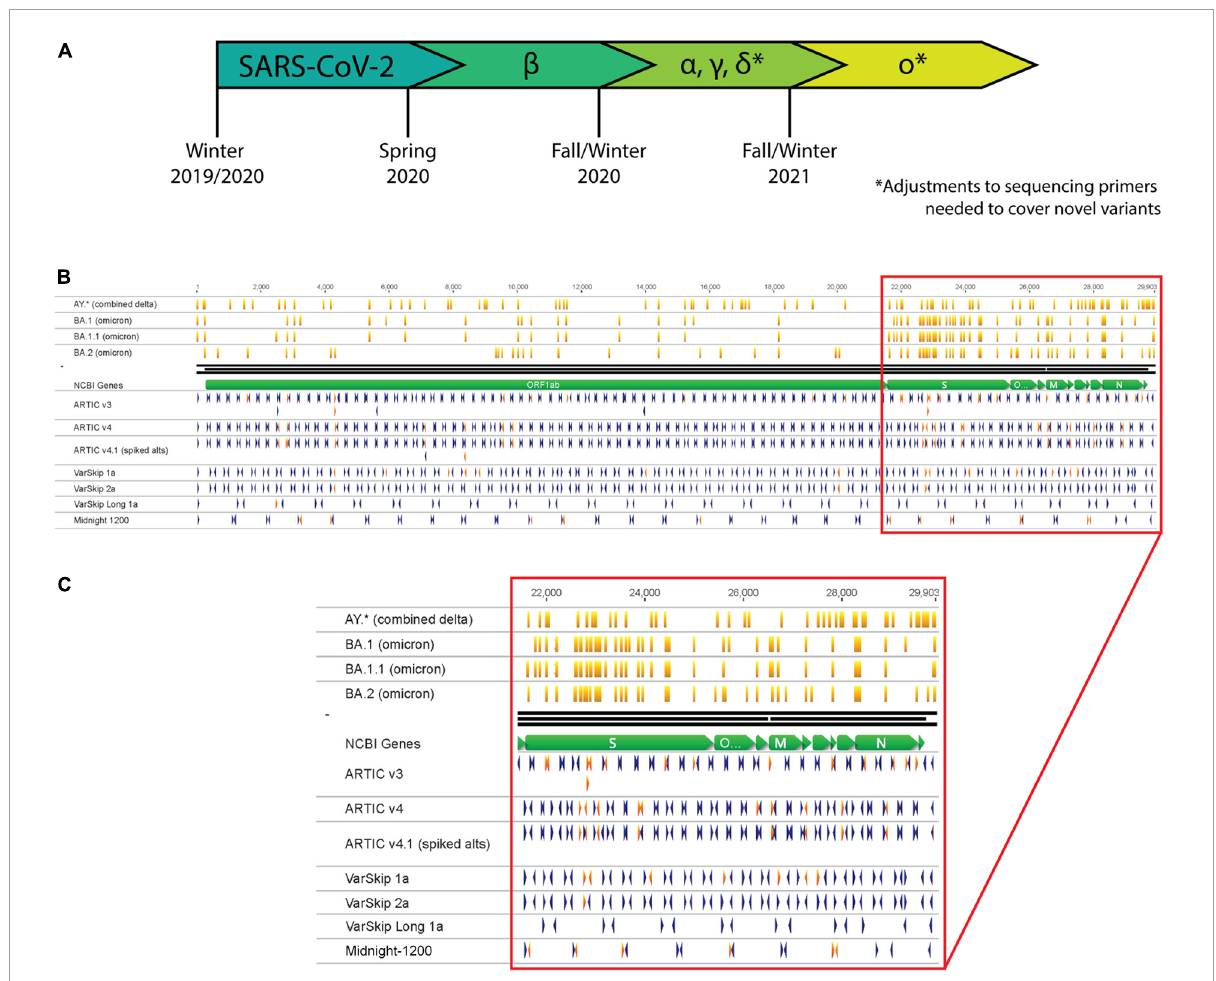
FIGURE1 SARS-CoV-2 variants necessitate continual assessment of primers utilized for sequencing as variants overlap with primer sites. (A) Timeline representing the emergence of SARS-CoV-2 variants as determined by continual variant monitoring via sequencing. (B) Analysis of Delta and Omicron variants overlapping with primers from several SARS-CoV-2 primer schemes. Orange vertical lines mark mutation locations along variant strains. Blue and red arrowheads mark primer locations and orientations; red arrowheads are primers that overlap with mutation sites in one or more variant strains. (C) Zoom-in of primer-variant overlap analysis in the S gene to N gene region of the